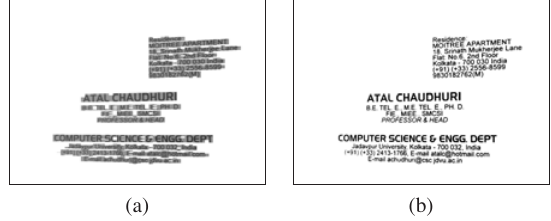
Figure 6. Two types of ground truth images generated for the first image of Fig- ure 5 (a). (a) Ground truth image at region/component level where only text com- ponents are kept and non-text components are removed. (b) Ground truth image at pixel level where text regions of the region level ground truth image are